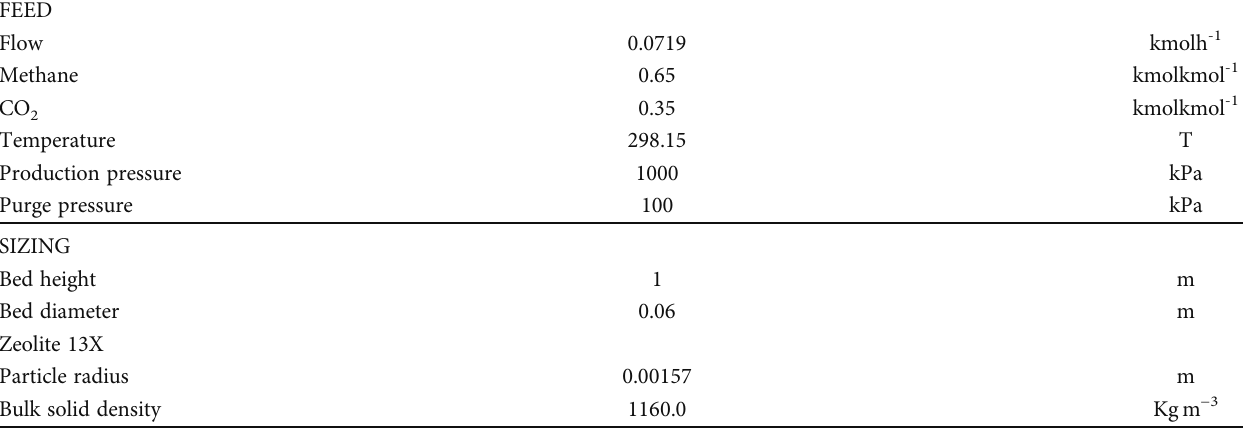
Table 24: Start-up parameters of the PSA process for the puri fi cation and production of biomethane.